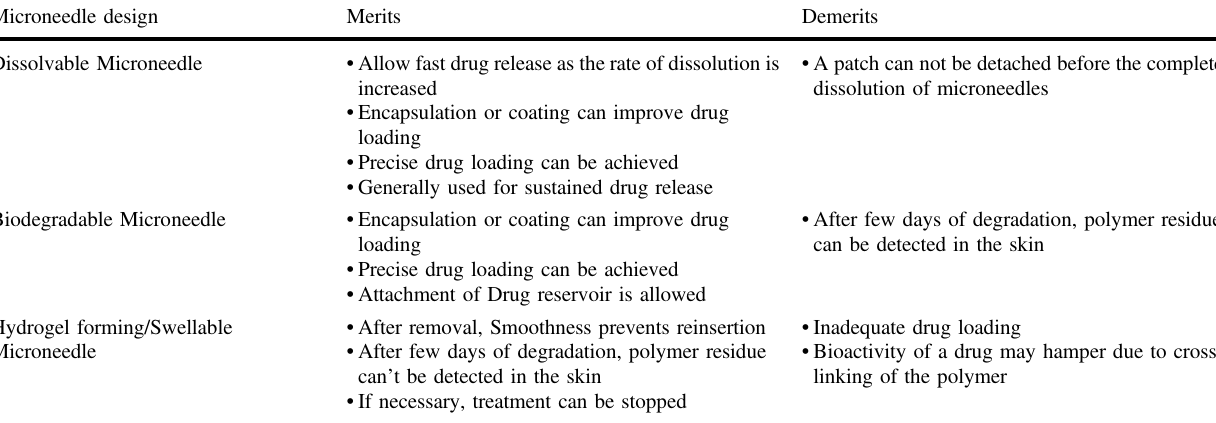
Table 4 Merits and demerits of dissolvable, biodegradable, and swellable carbohydrate-based microneedles [54] Microneedle